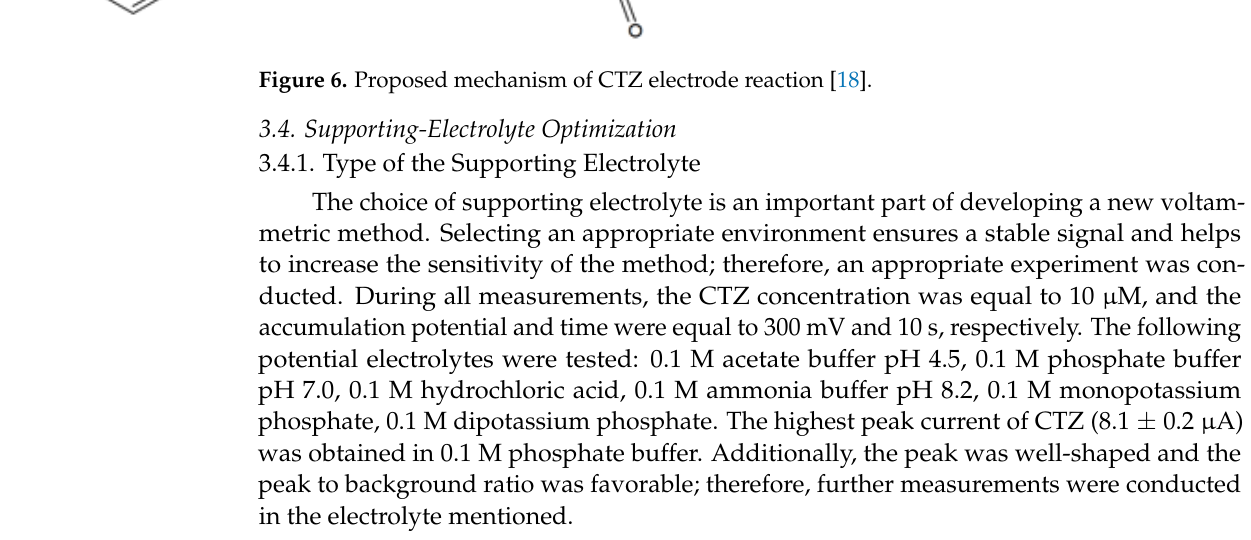
Figure 6. Proposed mechanism of CTZ electrode reaction [18].